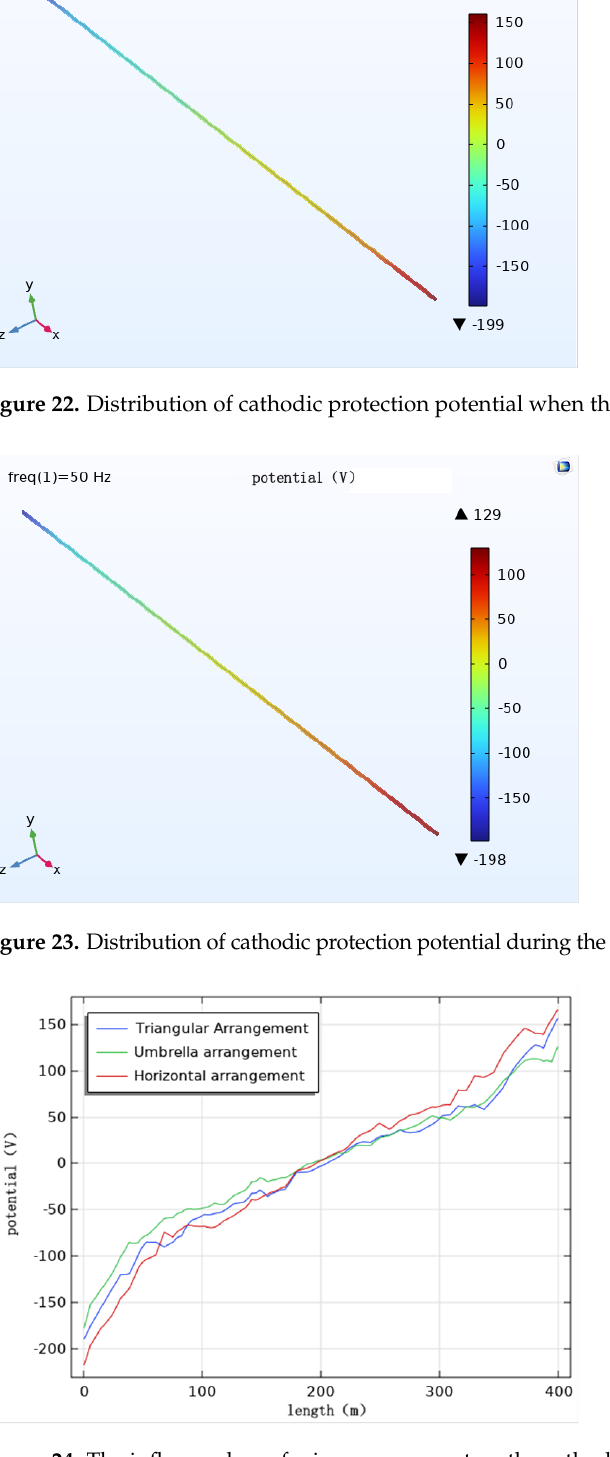
Figure 24. The influence law of wire arrangement on the cathodic protection potential.